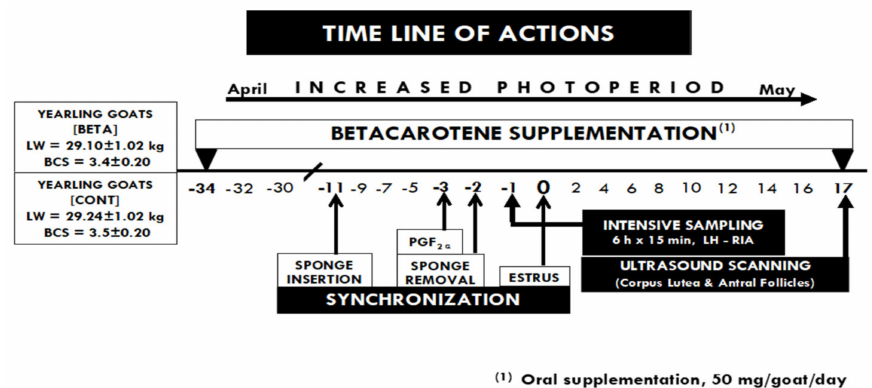
Figure 1. A graphic illustration of the experimental protocol, including the duration of long-term beta-carotene supplementation and estrous synchronization (for more details, see the text). An intensive blood sampling (every 15 min for 6 h) for luteinizing hormone (LH) measurements was performed 36 h prior to the estrus day (day 0). Thereafter, an ultrasonography scanning was performed on day 17 post-estrus to relate the LH secretion pattern and total ovarian activity (TOA = corpus lutea + antral follicles), measured as number of the observed structures present in each ovary on day 17 post-estrus, in yearling crossbred goats ( n = 22) supplemented with beta-carotene or serving as controls and